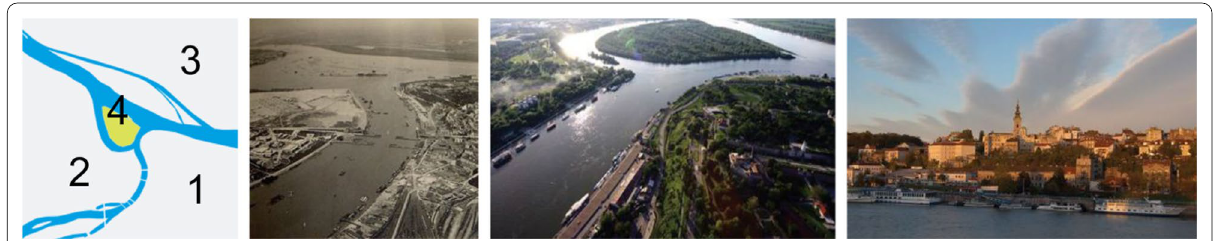
Fig. 3 City structure, Green Heart, fluvial Boulevards and panoramic view of Belgrade